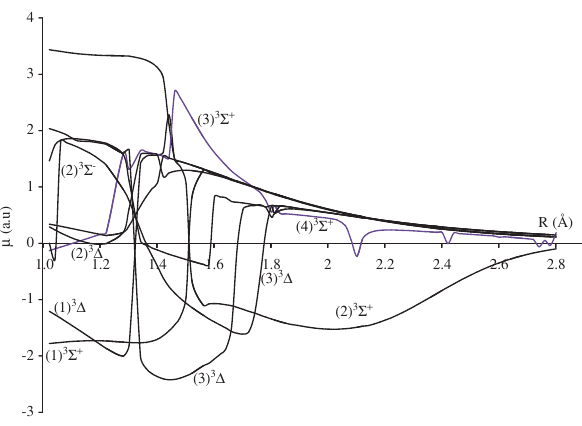
Figure 7: Dipole moment curves of the electronic states 3 Σ ± and 3 Δ of the molecule BF.